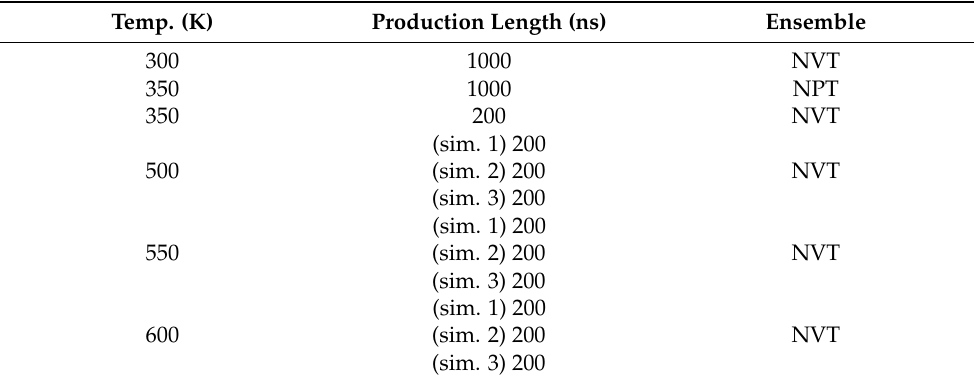
Table 5. Production length and ensemble conditions of simulations at different temperatures. Temp.